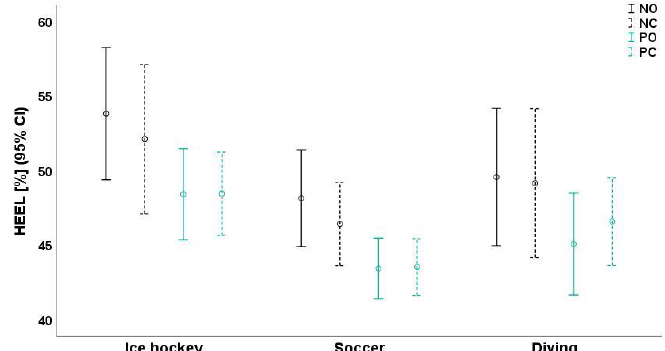
Figure 4. Anterior–posterior load distribution (HEEL%) between sports during four test conditions (NO, NC, PO, PC). Values are provided as mean and 95% CI.